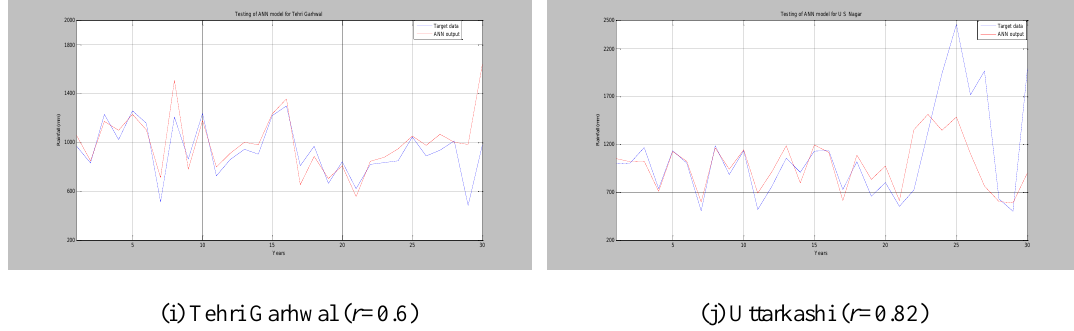
Fig. 5 (a-j). Testing of developed ANN Model for various districts of Uttarakhand State